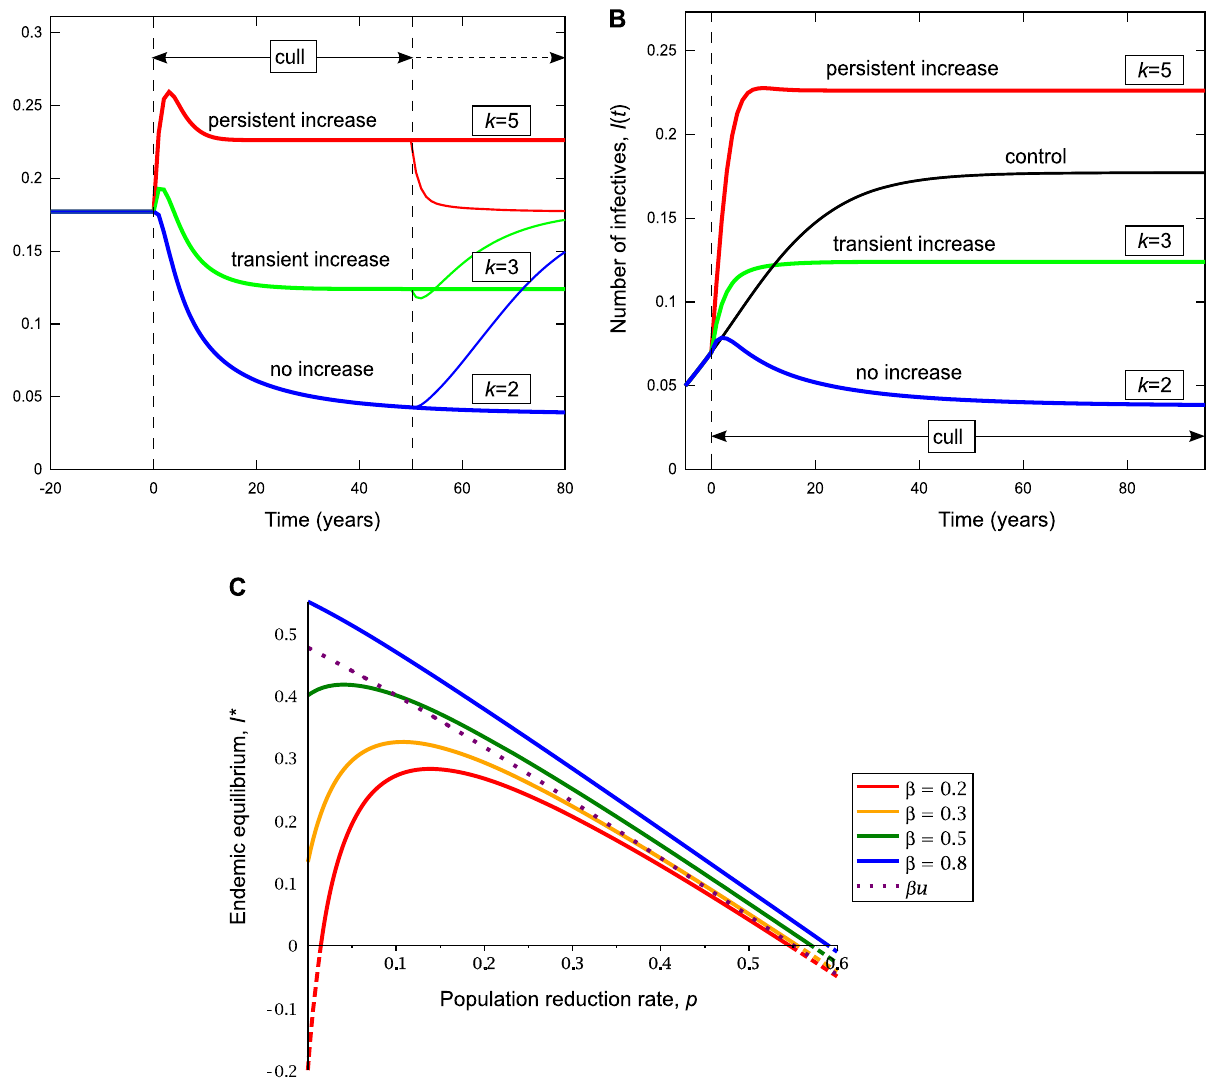
Figure 1. Deterministic simulation of I ( t ), and algebraic solution of I * ( p ). The results of ongoing population reduction are shown for various levels of disease enhancement k in (A) endemic disease, (B) emergent disease (starting near the disease free equilibrium, I (0) ~ 0 : 05 ). (C) shows the endemic equilibrium for varying b . The lines cut the vertical axis at I (cid:2) (0) , and so the perturbation effect occurs whenever a line rises above this value. Note that for b =0.2, the equilibrium is negative for small p (which cannot be reached, since only a non-negative number of individuals is biologically ~ 0 , and the perturbation effect does not occur possible), and so if any disease is introduced for p =0, it moves to the disease free equilibrium I (cid:2) DF until p is sufficiently high. The dotted line shows b u (see text for details), marking the upper bound of b for given p for which the perturbation effect is possible, and crosses each line at the point where the increase no longer occurs for that value of b ( b u is also illustrated in Fig. 2A). Parameters are given in Table 2, except p =0.2 in (A) and